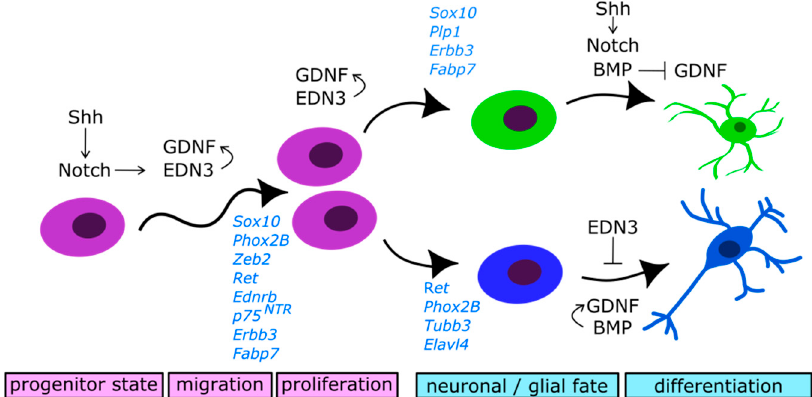
Figure 3. Schematic of enteric neural differentiation showing regulatory signalling pathways and marker gene expression. Several signalling pathways promote or inhibit key processes like ENCC (purple) migration, proliferation and differentiation of neuronal- and glial-fated progenitors (blue and green). Generally accepted markers for each cellular subpopulation are indicated in blue.